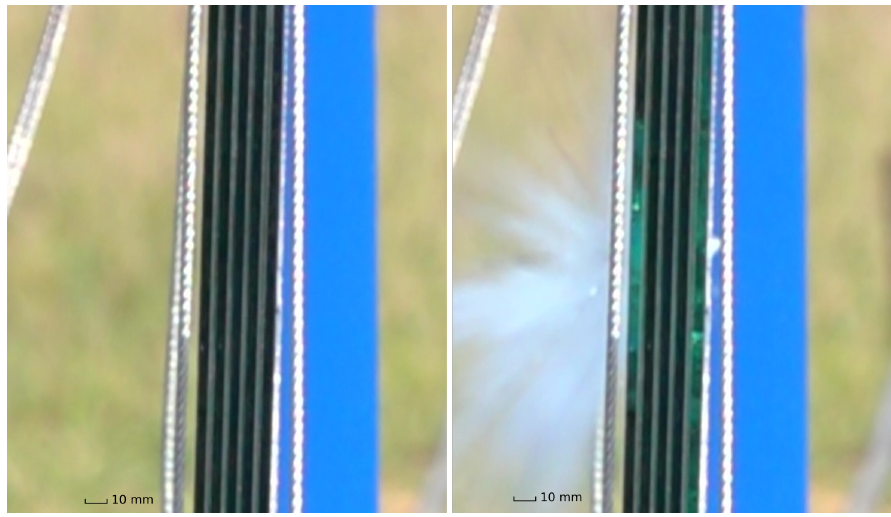
Figure 5. An example of high-speed camera frames from which glass damage was analyzed. ( Left ) before impact; ( right ) directly after impact. Impact direction from the left, both front and back plates damaged. Table 4. Impact testing damage and subsequent quasi-static peak forces.